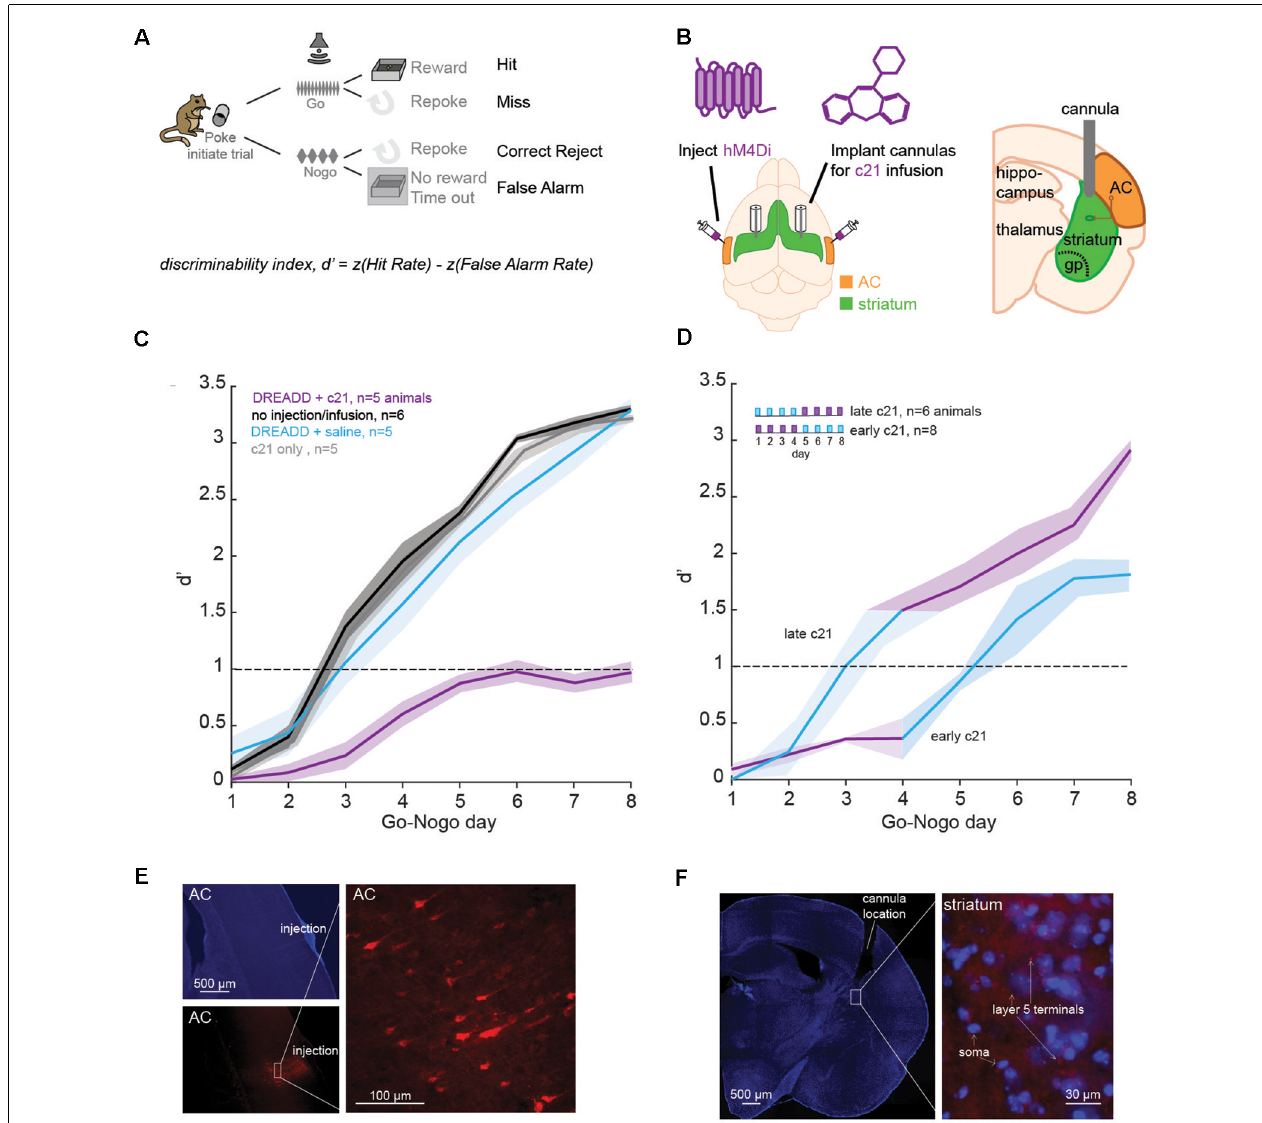
FIGURE 1 | Suppression of the corticostriatal pathway impacts learning. (A) Go-Nogo discrimination task. A performance measure, d (cid:48) is computed for each animal and for each Go-Nogo session. (B) Illustration of the surgical procedure in which bilateral injections of iDREADD are performed in the auditory cortex (AC), followed by cannulae insertions in the auditory striatum. Local infusions of the activating agent, c21, or saline were carried out prior to behavioral testing. (C) Mean ( ± SEM) d (cid:48) measures across Go-Nogo days for different groups tested: (1) in purple, animals with iDREADD injections and c21 infusions, (2) in black, animals without iDREADD injections and without any infusion, (3) in blue, animals with iDREADD injections and saline infusions, and (4) in gray, animals without iDREADD injections but with c21 infusions. (D) Mean ( ± SEM) d (cid:48) measures for two additional groups: (1) late c21 animals with iDREADD injections and saline infusions on days 1–4, followed by c21 infusions on days 5–8, and (2) early c21 animals with iDREADD injections and c21 infusions on days 1–4, followed by saline infusions on days 5–8. (E) Photomicrographs confirming the injection site of iDREADD with labeled AC cells (mCherry). (F) Confirmation of the position of implanted cannulae in the